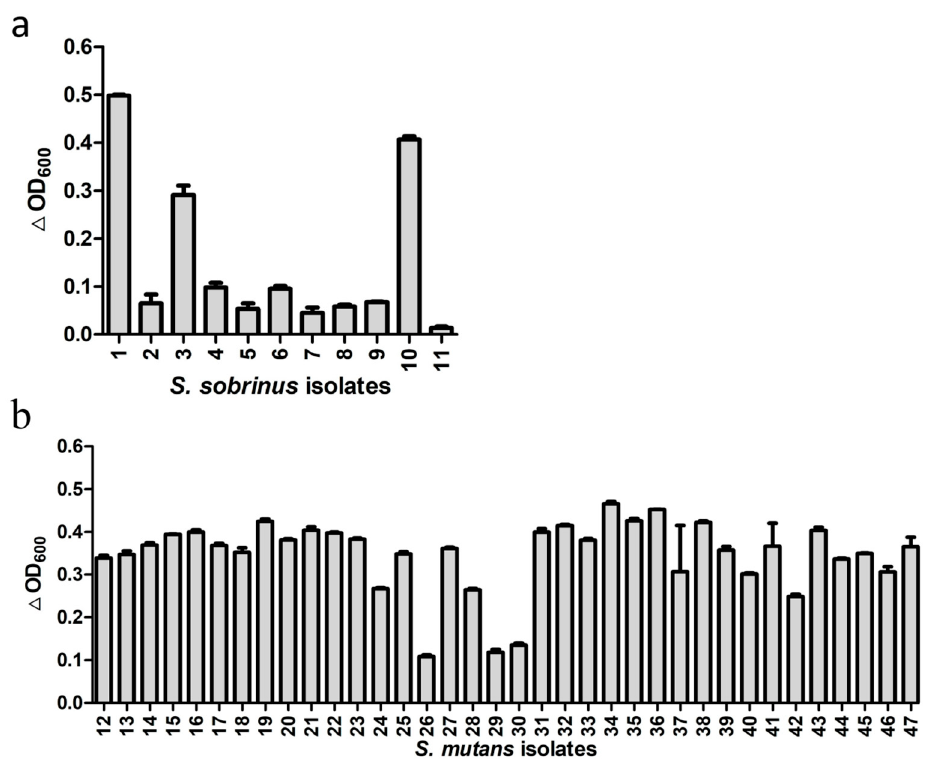
Figure 2. Activities of ClyR against multiple clinical isolates. S. sobrinus ( a ) and S. mutans ( b ) isolates were grown to logarithmic phase, suspended in PBS buffer to an OD 600 of ~0.8, and then treated with 50 µg/mL of ClyR at 37 °C for 10 min. The relative change in OD 600 ( ∆ OD 600 ) of each well was determined by subtracting the decrease of OD 600 in the PBS-treated control well.